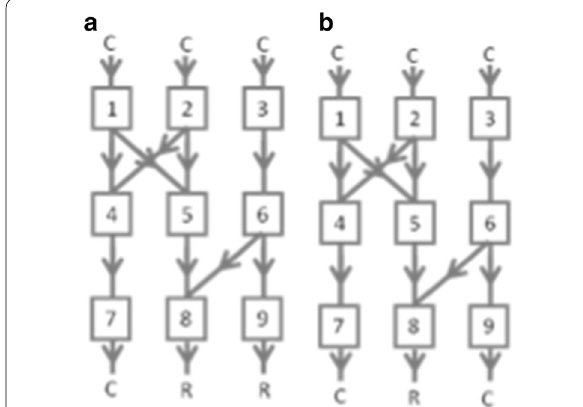
Fig. 2 Tank networks with two (panel A) and one (panel B) rusty network outputs. Water flows from top to bottom. “R” means rusty water in a pipe. “C” means clean